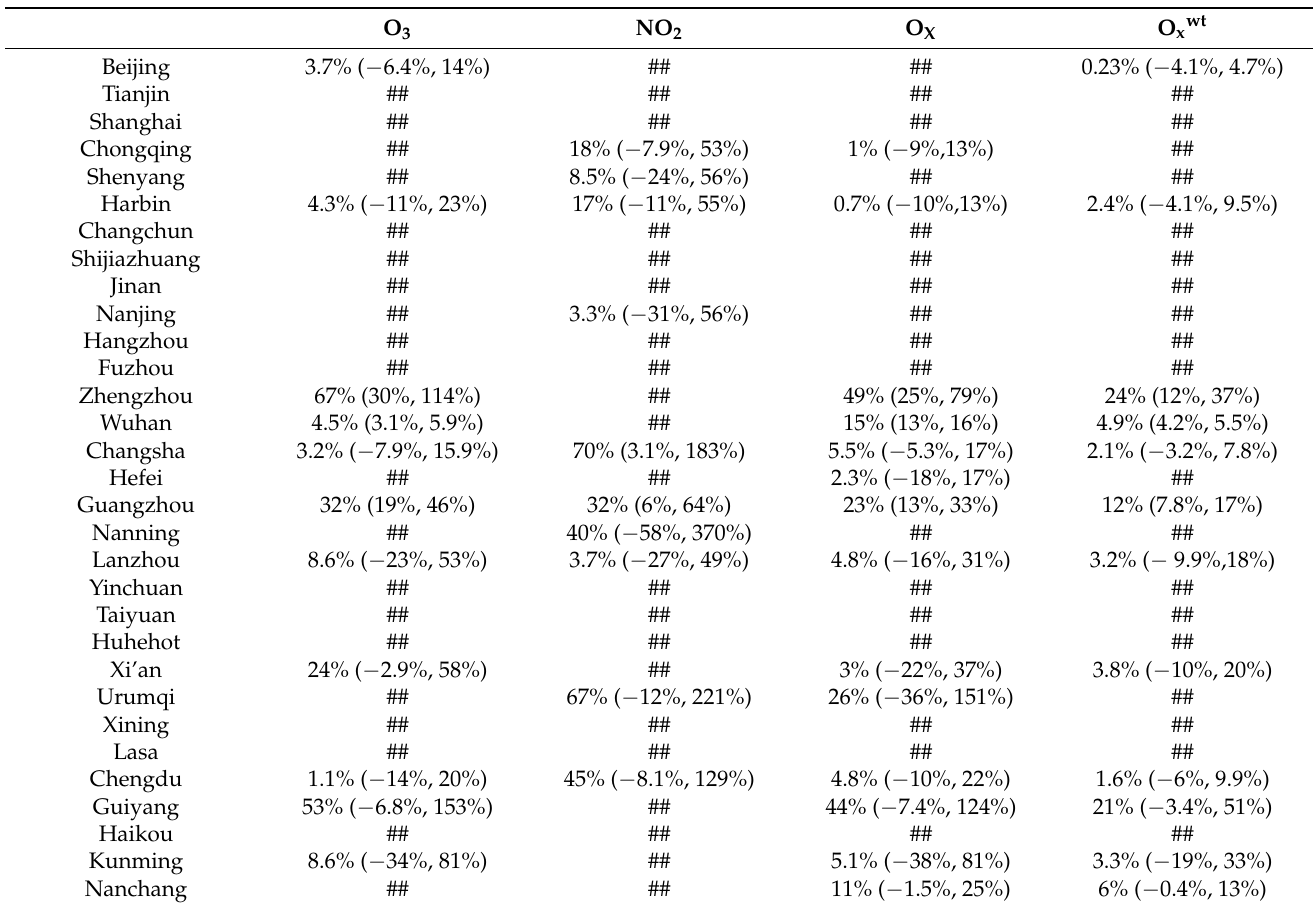
Table 1. Single pollutant effect for COVID-19 in some China cities. O 3 O